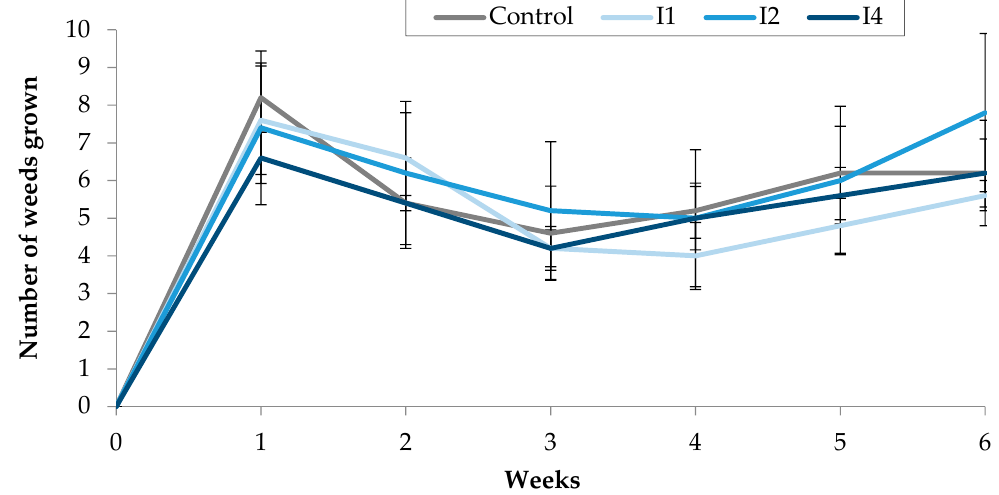
Figure 5. Effect of TC3, injected into the soil, on the number of weeds grown in treated pots. Phytotoxic Activity of TC3 Supplied with Water, Using Tween 20 as Emulsifier and Applied by